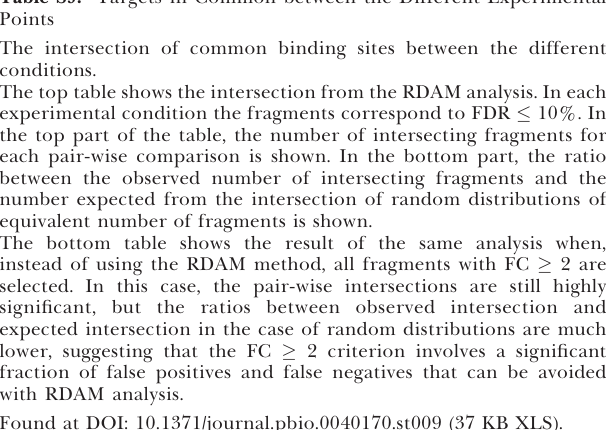
Table S7. Comparison between RDAM and FC Detection Table S8. Correlation of Protein Distributions in the Different Conditions Table S9. Targets in Common between the Different Experimental Points The intersection of common binding sites between the different conditions.